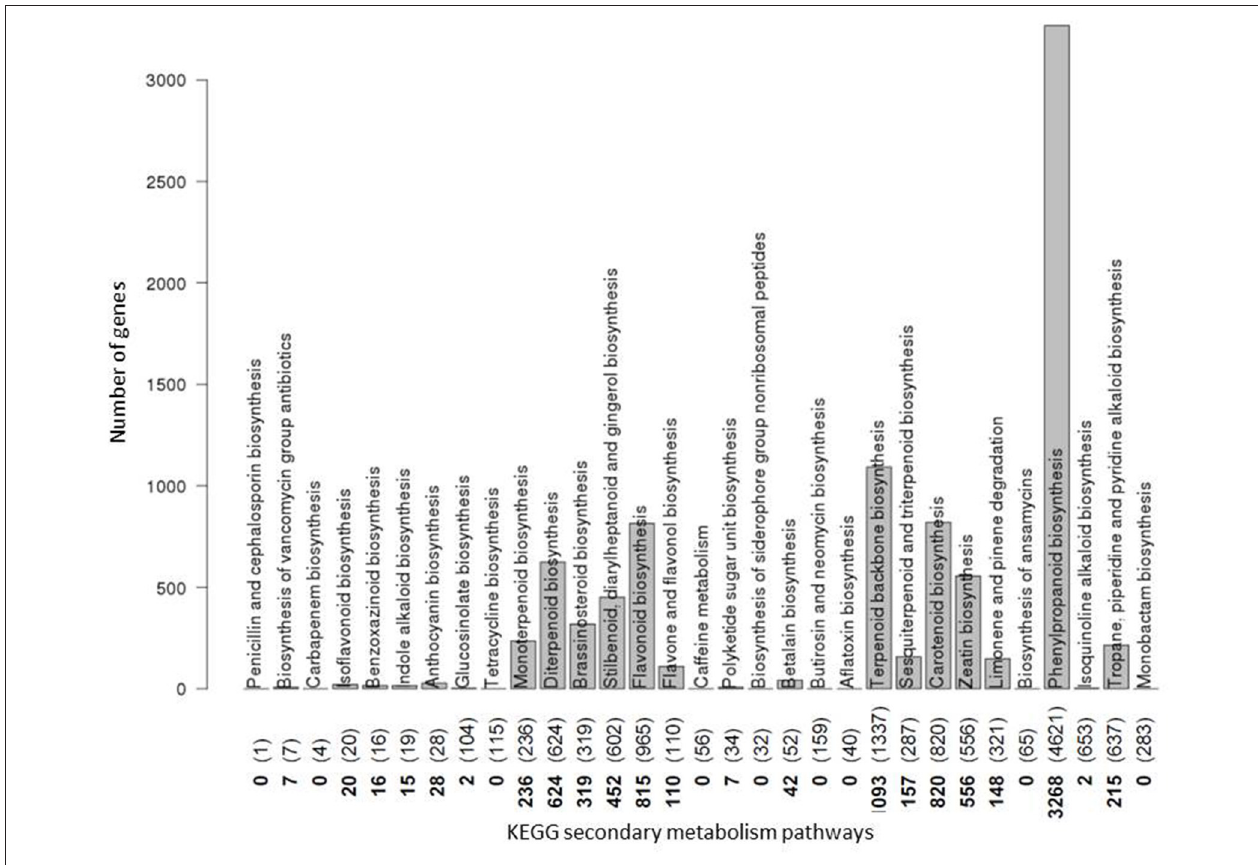
FIGURE 4 | Number of genes coding for enzymes involved in secondary metabolite pathways. The number of genes assigned to each plant secondary metabolite pathway as annotated in the KEGG database is plotted. Counts are based on all plant genes from any of the 24 plant species considered in this study. Numbers along the abscissa denote the actual number of genes involved in secondary metabolism pathways only with numbers in parentheses referring to the respective counts when considering genes annotated to participate in both secondary and primary metabolism pathways. Pathways are indicated by their names. Pathways “Biosynthesis of vancomycin group antibiotics” as a bacterial pathway, and “Penicillin and cephalosporin biosynthesis” as a fungal pathway were not considered any further in this plant-focused study. For the pathways “Benzoxazinoid biosynthesis” and “Isoquinoline alkaloid biosynthesis,” while listed in KEGG, conflicting or no annotations were contained in Biomart and, therefore, were discarded from further analysis. All remaining 19 secondary metabolism pathways with non-zero KEGG gene counts were considered